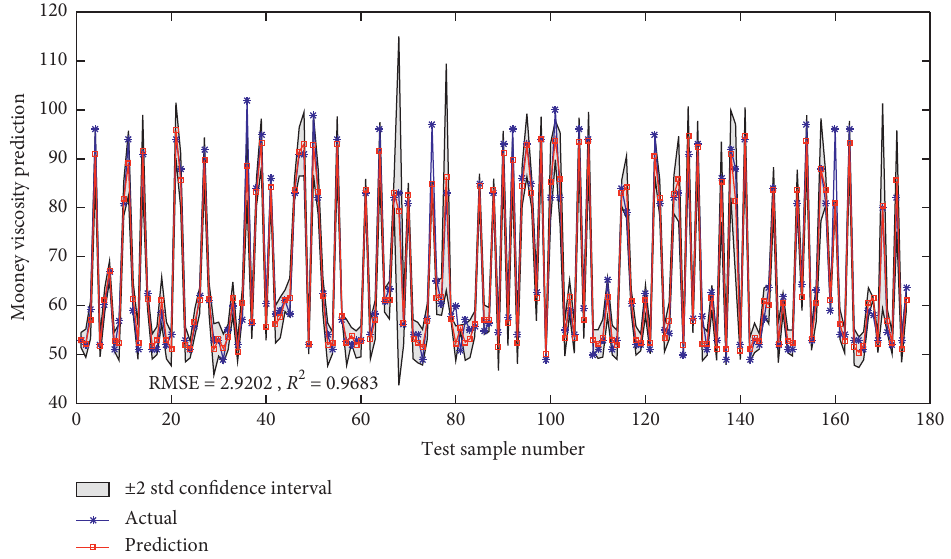
Figure 4: Trend plots of Mooney viscosity predictions using the proposed MP-EJITGPR (FMM) approach ( l � 10).